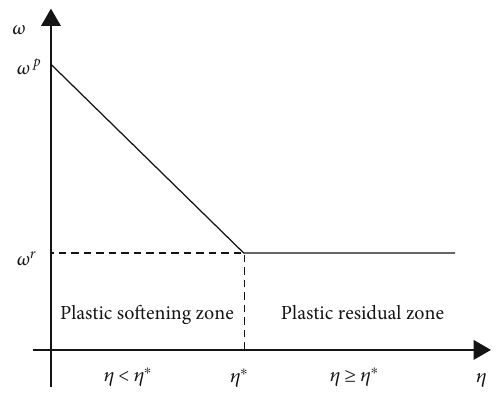
Figure 4: The relationship between strength parameters ω and η in plastic zone